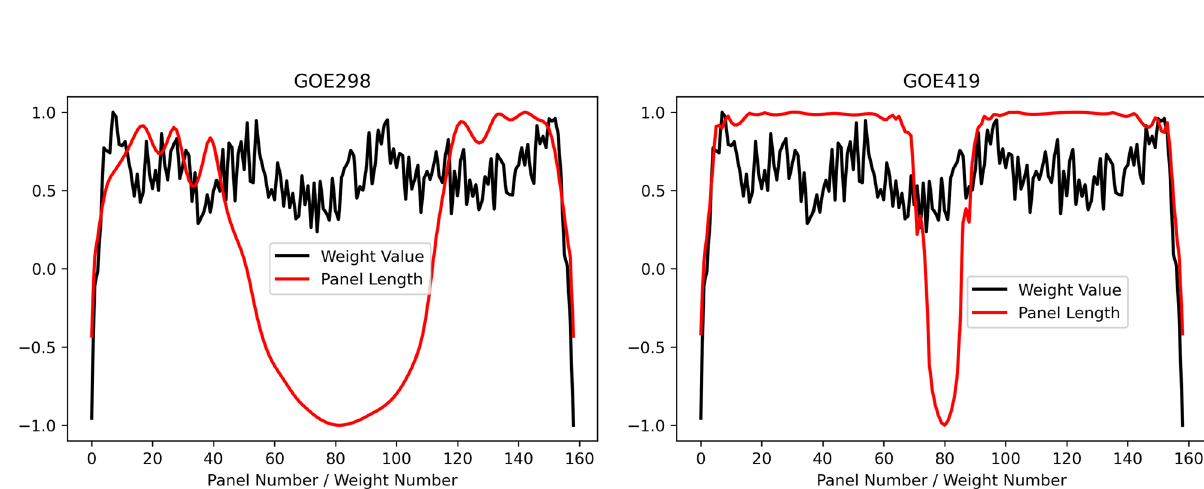
Figure 12. Comparison of learned weights and panel length distribution at the same